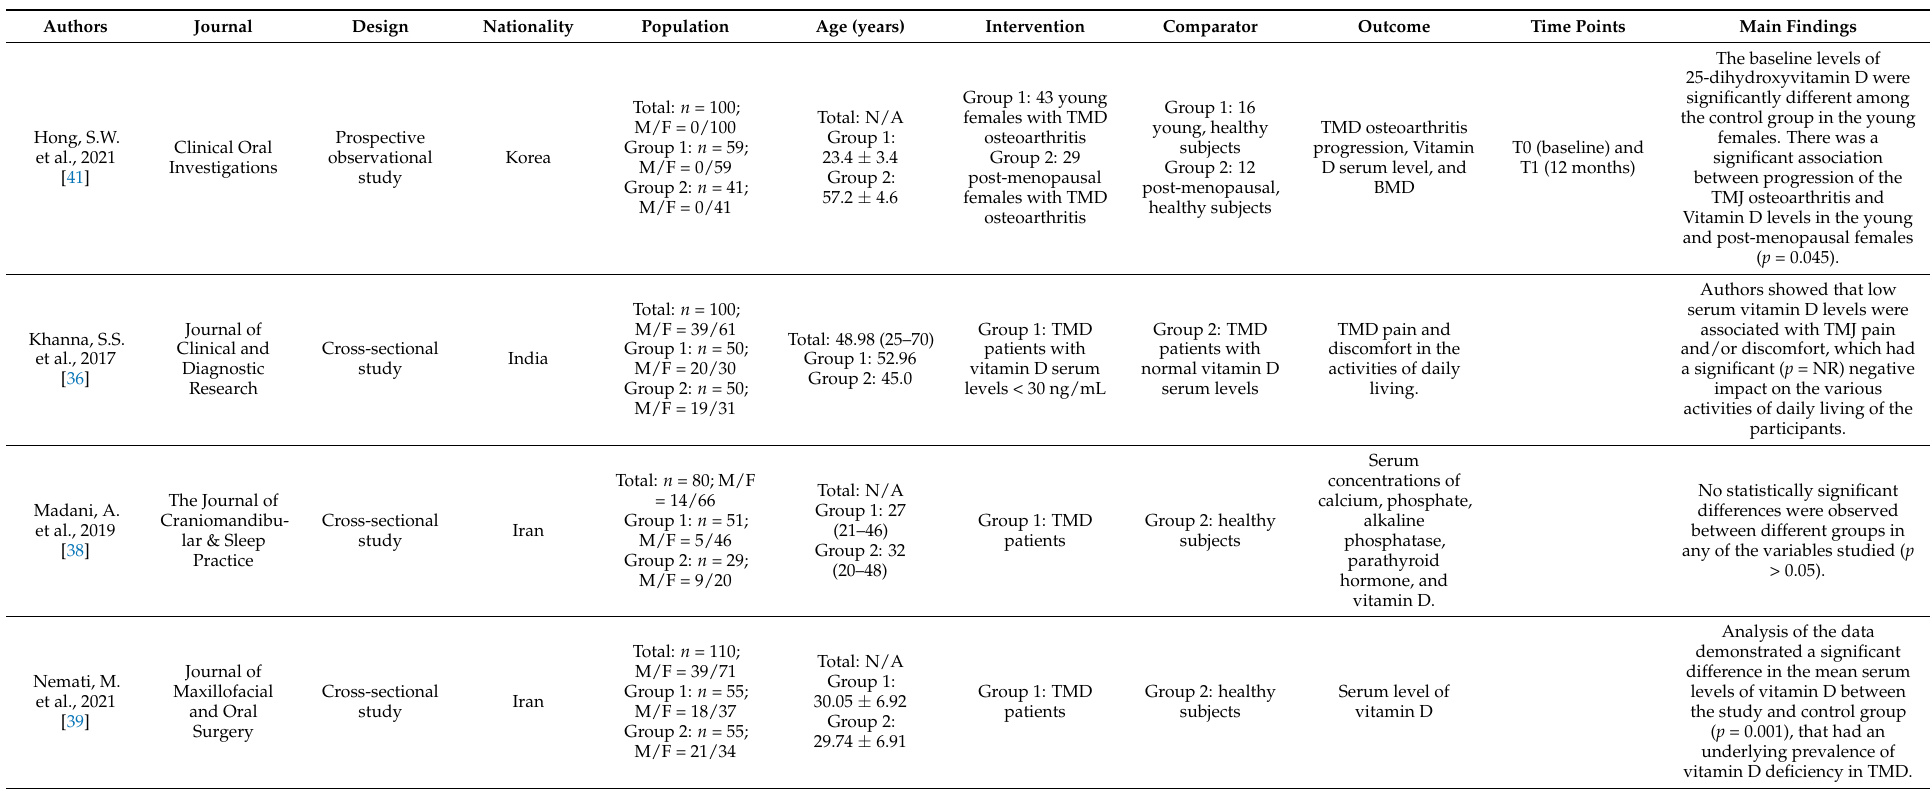
Group 1: TMD patients